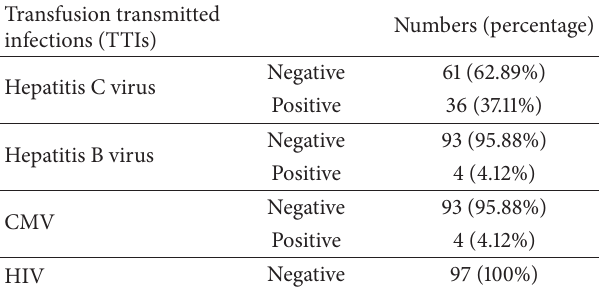
Table 2: Prevalence of transfusion transmitted infections (TTIs) in thalassemic